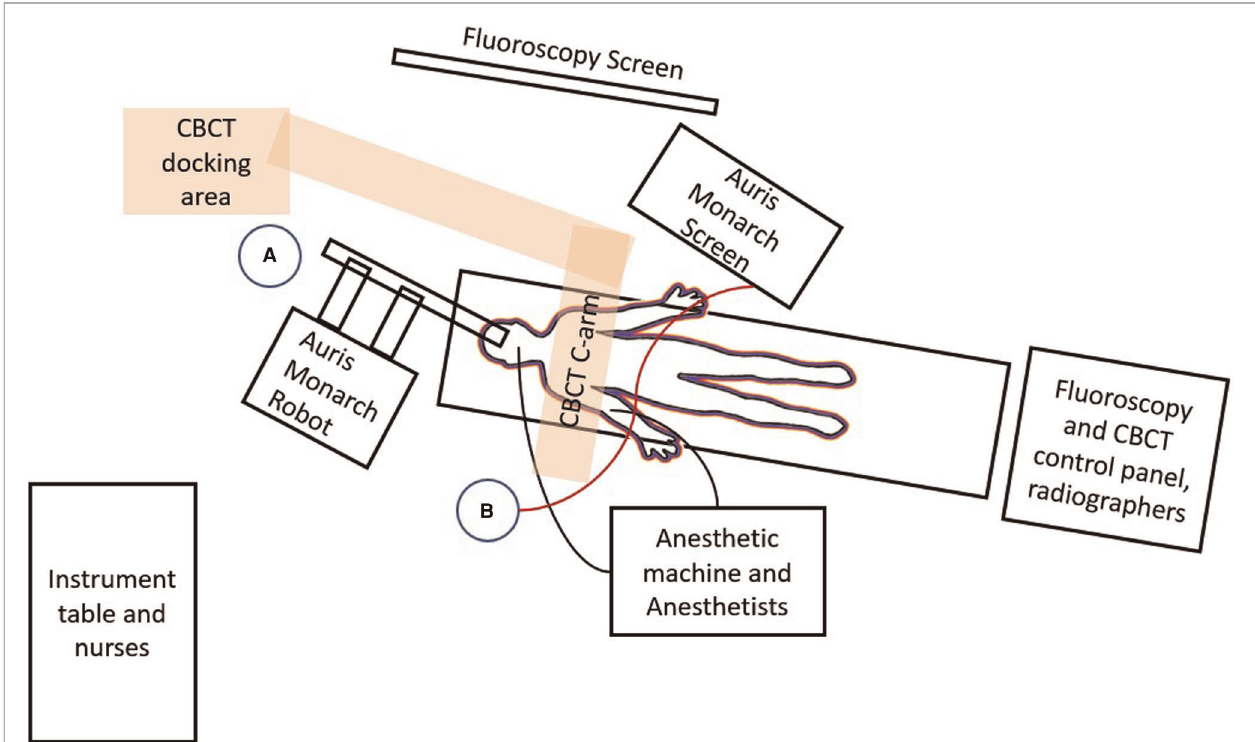
FIGURE 6 | Floor plan of the hybrid operating room setup for robotic ENB procedures in our institution is shown. The patient lies on a radiolucent operating table and is intubated and connected to the anesthetic machine on his right side via numerous monitoring lines. The Auris Monarch Robot is parked at the head-side of the table with robotic bronchoscope entering the airways through the endotracheal tube. The fl uoroscopy screen, and the Auris Monarch Screen showing virtual bronchoscopy and navigation pathways, is parked on the patient ’ s left. The CBCT (orange rectangle overlying the patient ’ s thorax) rotates around the patient, while the CBCT docking area is fi xed to the ground. Operator A stands close to the Robot in order to control instruments within the robotic bronchoscope, for example advancing needle or injecting dye. Operation B stands at the patient ’ s right side and controls the advancement and direction of the robotic bronchoscope via a wired steering control (red line) which is connected to the Auris Monarch Machine/screen. Both operators should see both the fl uoroscopy and Auris Monarch screen and remain in close communication with each